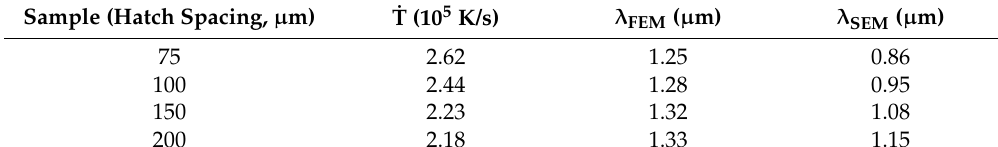
Table 4. Summary of grain size based on simulation and SEM micrographs.